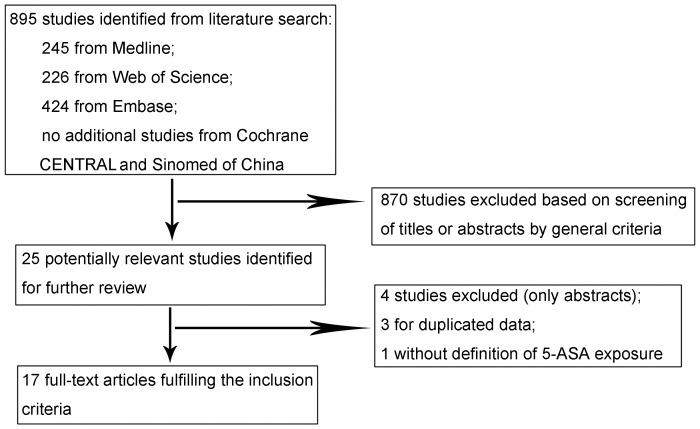
Flowchart of literature search for meta-analysis.